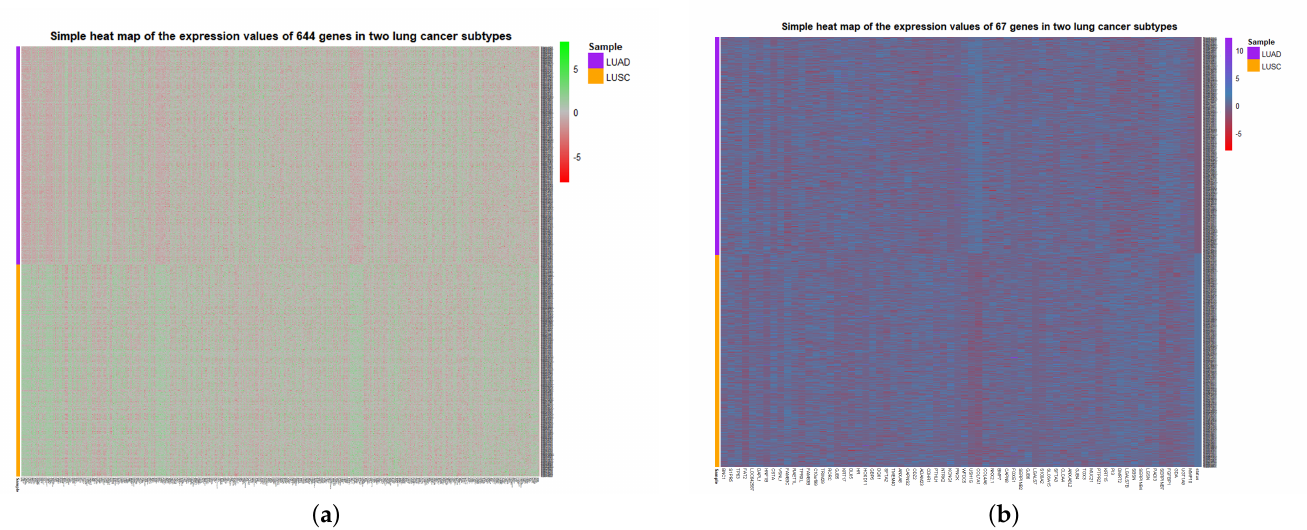
Figure 4. Simple heat map of gene expression for the genes selected in identifying two cancer subtypes. ( a ) The simple heat map of the expression of 644 genes. ( b ) Simple heat map of the expression of 67